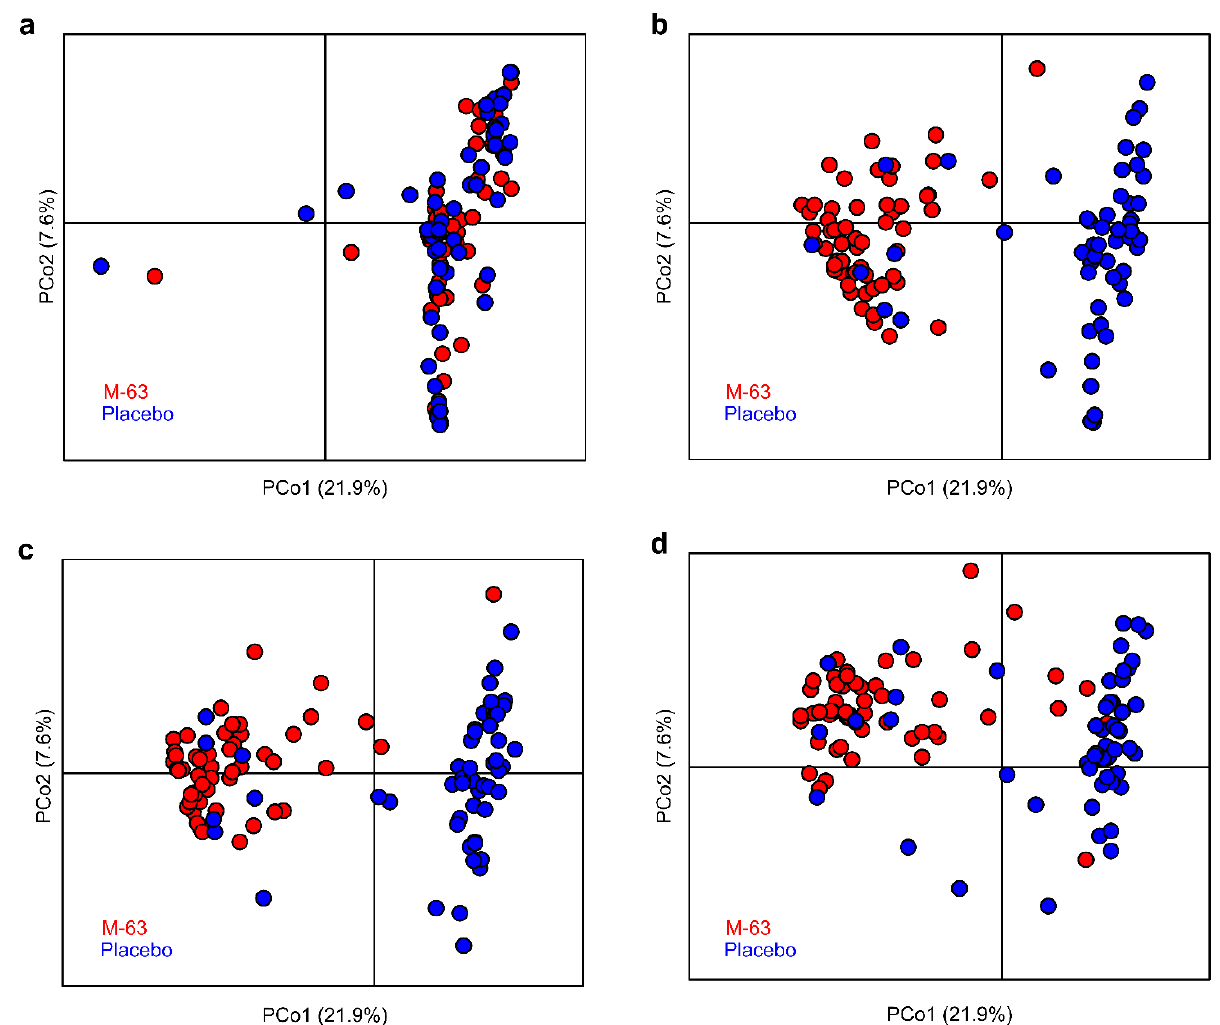
Figure 3. Dynamics of enterotype in each group during the intervention. PCoA of fecal microbiota in each group based on JSD calculated by the fecal microbiota composition at the ASV level. ( a ) Before ingestion; ( b ) 1 week after ingestion; ( c ) 1 month; ( d ) 3 months of age. Blue and red symbols indicate subjects in the placebo and M-63 groups, respectively. Table 2. The relative abundance of Bifidobacterium and percentage of infants in which Bifidobacterium was the most dominant